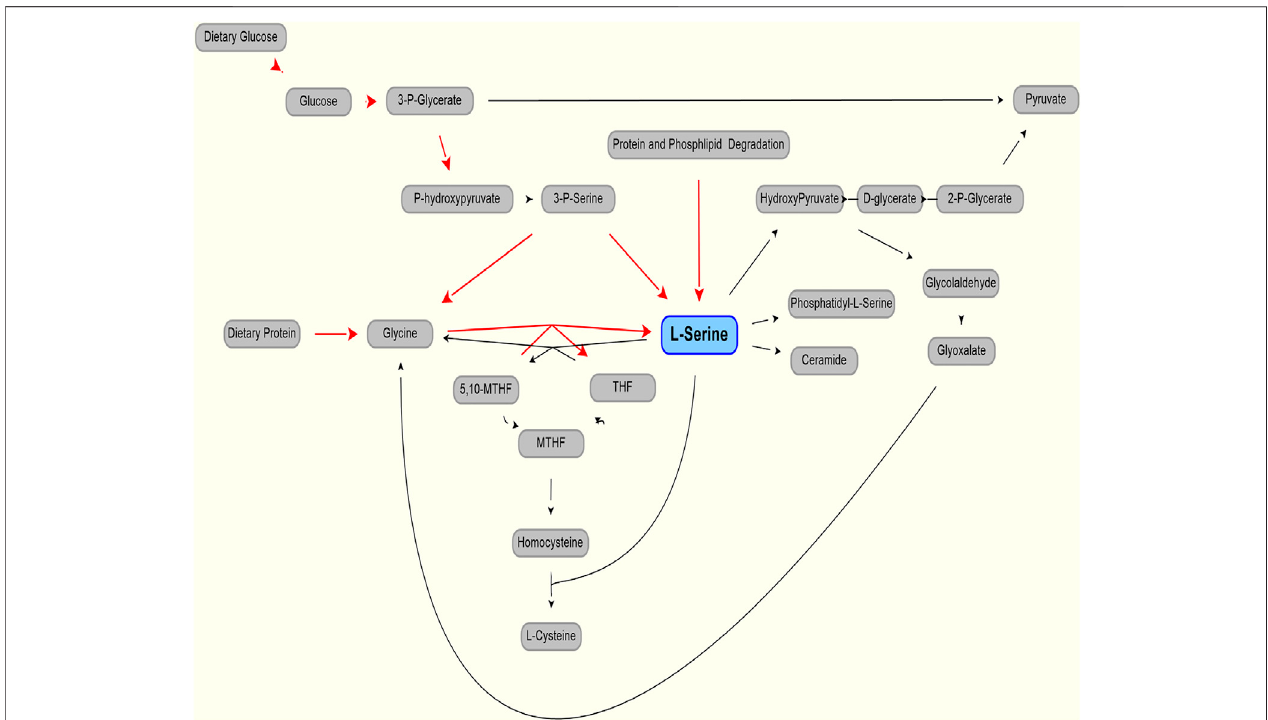
FIGURE 1 | Production (red line) and use (black lines) of L-serine in the body. Modi fi ed from (de Koning et al., 2003).